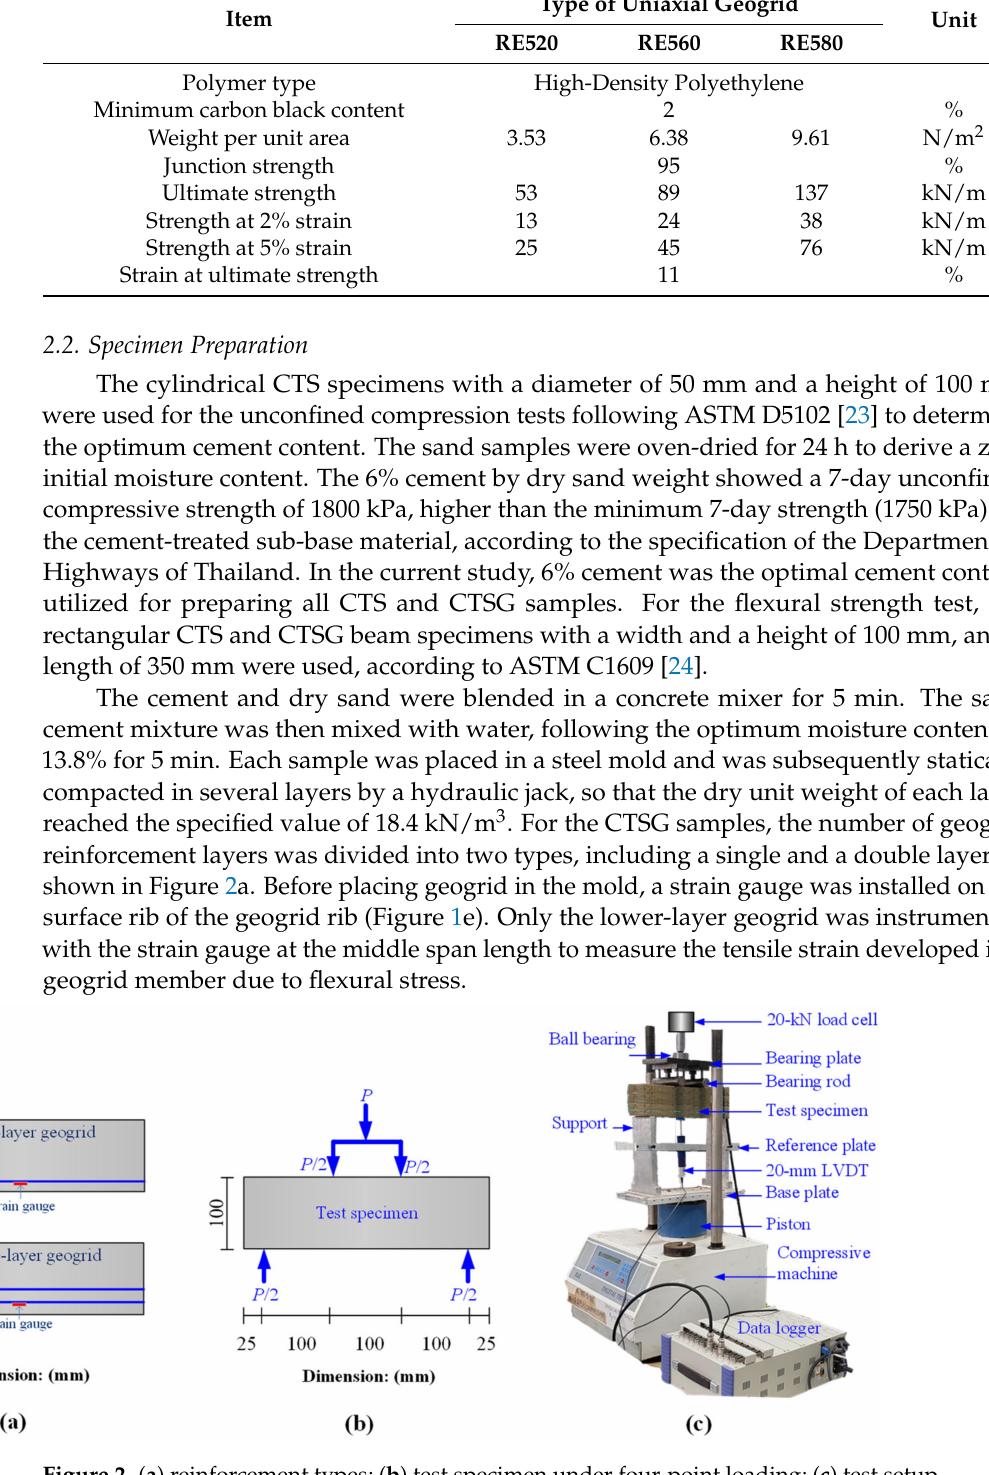
Figure 2. ( a ) reinforcement types; ( b ) test specimen under four-point loading; ( c ) test